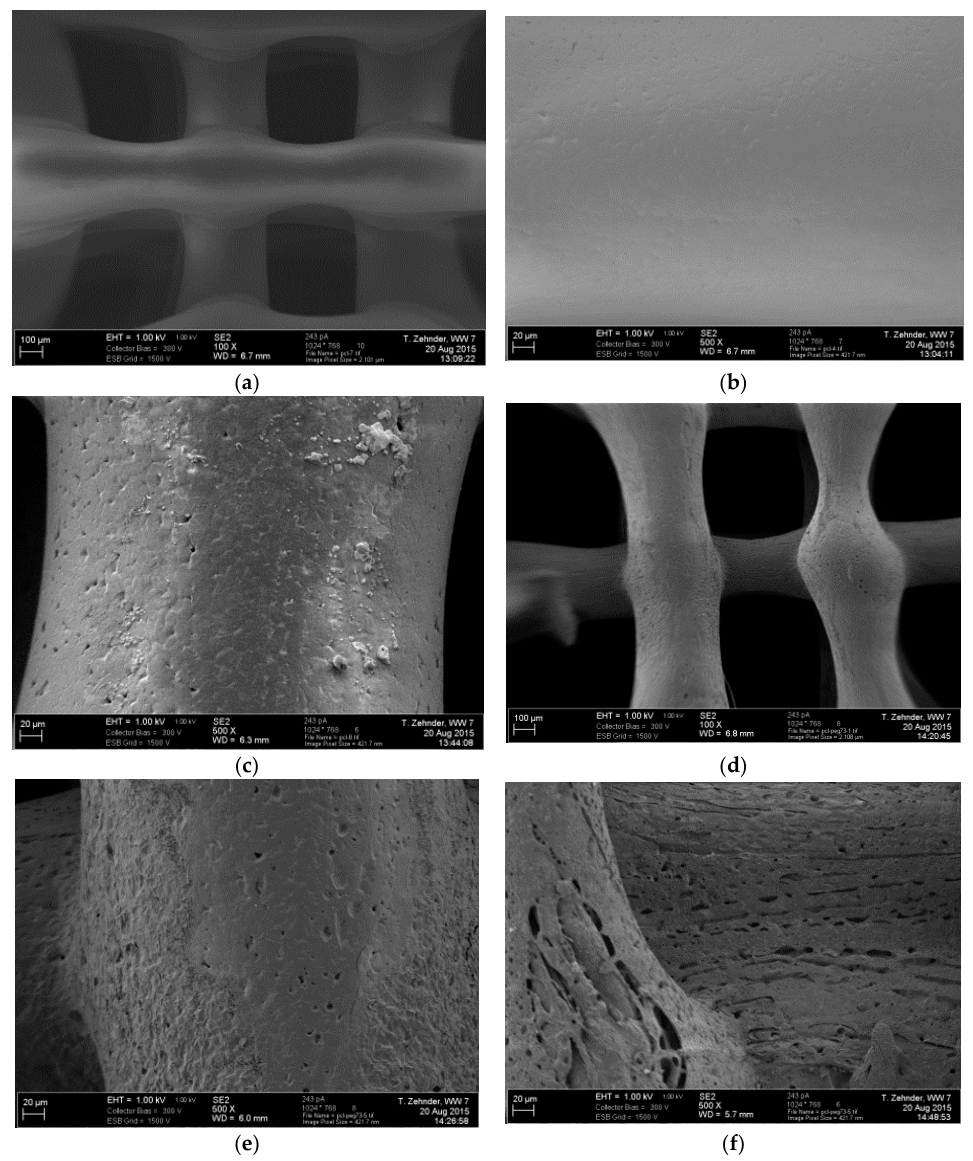
Figure 8. Electron microscopy images of the surfaces of PCL scaffolds as fabricated ( a , b ), and after three days of incubation in HBSS ( c ); and PCL-PEG 7030 scaffolds as fabricated ( d , e ), and after three days of incubation in HBSS ( f ) at 37 °C.